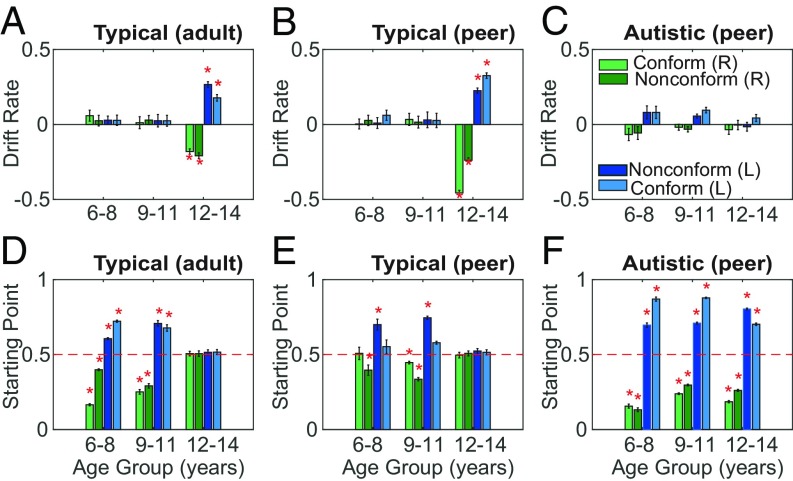
Drift rates and starting point estimates by social influence direction and conformity for the best-fitting drift diffusion model. (A) For neurotypical children aged 12 to 14 y, median drift rates systematically changed with the direction of adult social influence, whether they conformed or not. No such change in drift rate is apparent for younger children. Error bars show 95% confidence limits; an asterisk denotes a significant deviation from zero (Wilcoxon rank sum, P < 0.00001, Bonferroni corrected for significance at P < 0.05). (B) A similar pattern of drift rate changes with social influence direction is apparent for 12- to 14-y-old neurotypical children advised by a peer. The effect on drift rate appeared stronger when children conformed with advice. Conventions as in A. (C) For autistic children, we found no significant changes of drift rate with social influence direction or with conformity. Conventions as in A. (D) When estimating starting points by social influence direction and level of conformity with an adult advisor, we found that the two younger age groups of neurotypical children showed a significant deviation from the midpoint in the direction of social influence, but 12- to 14-y-olds showed no significant bias in starting point. Error bars denote 95% confidence limits; an asterisk shows a significant deviation of the starting point from 0.5 (Wilcoxon rank sum, P < 0.00001, Bonferroni corrected for significance at P < 0.05). (E) Neurotypical children showed a very similar pattern of starting point bias with age when advised by a peer or by an adult (D). However, the early bias in starting point appeared less strong. Conventions as in D. (F) Across all age groups, autistic children showed a strong bias in the starting point. Conventions as in D. For parameter estimates for Model 2 (starting bound only) and Model 3 (drift rate only), see SI Appendix, Fig. S5.